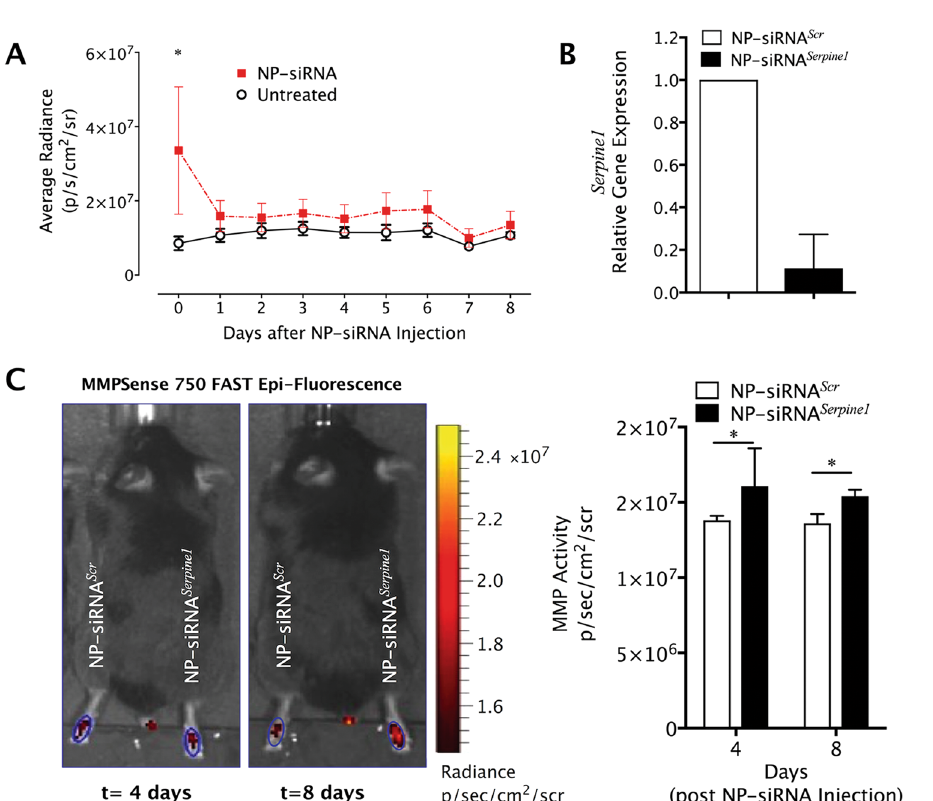
Figure 7. Nanoparticle-mediated delivery of siRNA localizes to the injury site, substantially clears within 24 hrs, but efficiently silences the target gene ( Serpine1 ) and enhances MMP activity in the tendon repair tissue. WT mice (n = 3 per treatment) received the standardized partial laceration of the FDP tendon in zone II of the third digit of each hind paw. The mice were then allowed to heal for 7 days, at which time the injured digits were injected with 5 μ l of NPs complexed with Cy3-labeled NP-siRNA Scr and NP-siRNA Serpine1 at a dose of 100 pmol/ μ l. ( A ) NP-siRNA retention was measured over 8 days using IVIS Spectrum and quantified in region of interest encompassing the injected paw as photon counts per second per unit area. ( B ) Serpine1 gene expression levels were measured using real-time RT-PCR from repair tissue in the injured digit, normalized to beta-actin as a house keeping gene and expressed relative to the NP-siRNA Scr treatment. ( C ) MMP activity was longitudinally measured using MMPSense 750 FAST reagent on days 4 and 8 post-injection using IVIS Spectrum and quantified in region of interest encompassing the injured paw as photon counts per second per unit area. Data are presented as mean ± standard deviation. Asterisks indicate significant differences between siRNA Scr and siRNA Serpine1 (p <